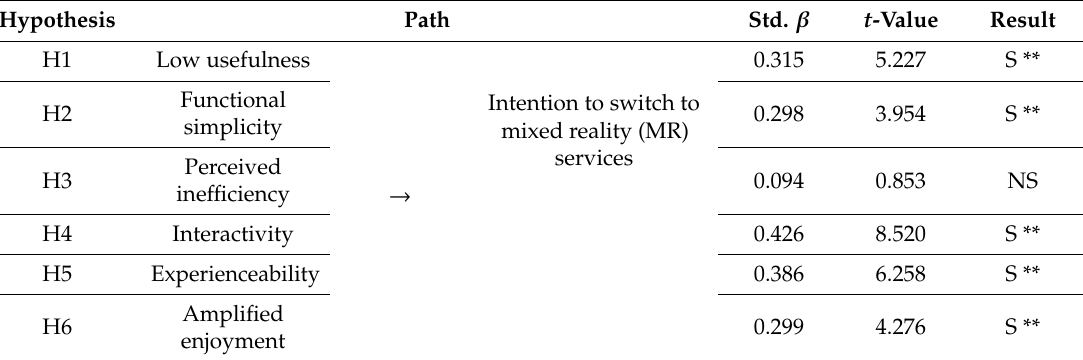
Figure 2. Results of the structural model (direct effects—H1 to H6). Table 6. Summary of hypothesis tests